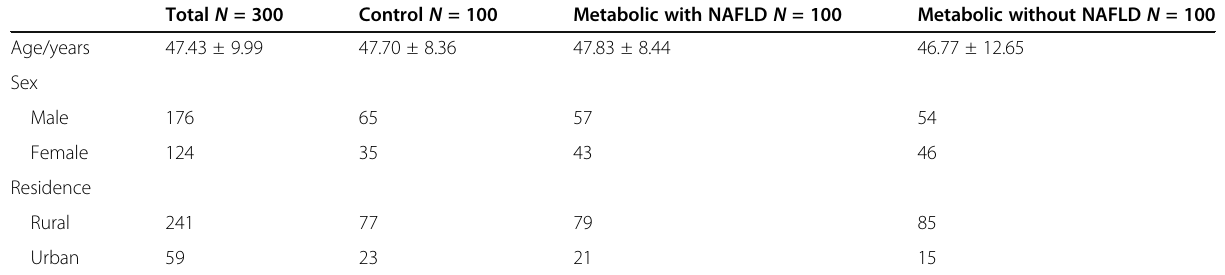
Table 1 Demographic characteristics of the studied groups